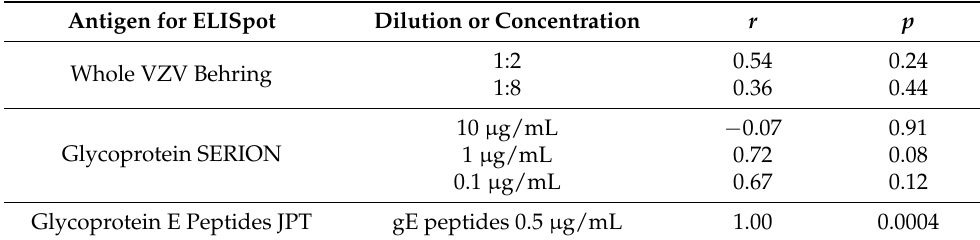
Table 3. Spearman correlation of ELISpot responses towards a peptide pool of gE (1 µ g/mL) and to- wards various other varicella-zoster virus (VZV) antigens in seven hematopoietic stem cell transplant recipients vaccinated with Shingrix™.